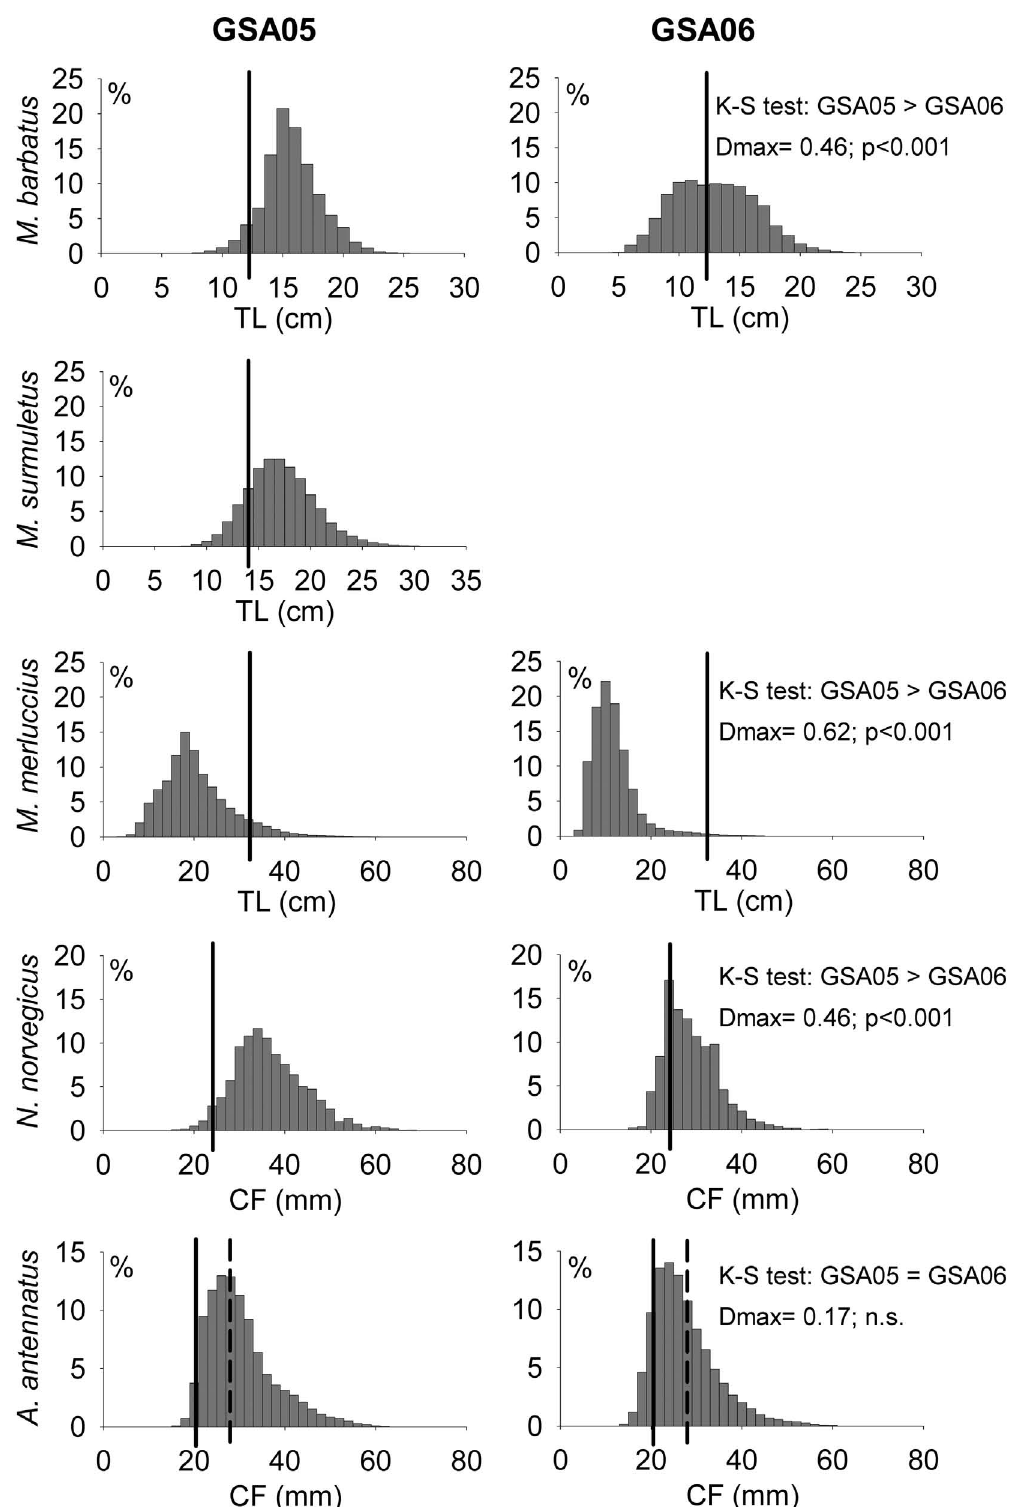
Fig . 5. – Landings size-frequency distributions (TL: total length; CF: cephalothorax length) of the main demersal target species in the geo- graphical sub-areas Balearic Islands (GSA05) and Northern Spain (GSA06). The figure also shows: 1) the results of the Kolmogorov-Smirnov (K-S) test used to compare the distributions of each species between GSAs; and 2) the size at first maturity (L of the population is mature (in the last graph, solid and dotted lines are males and females respectively). Data come from assessments pre- sented to the GFCM and there is no graph of Mullus surmuletus from GSA06 because up to now the species has not been assessed in this